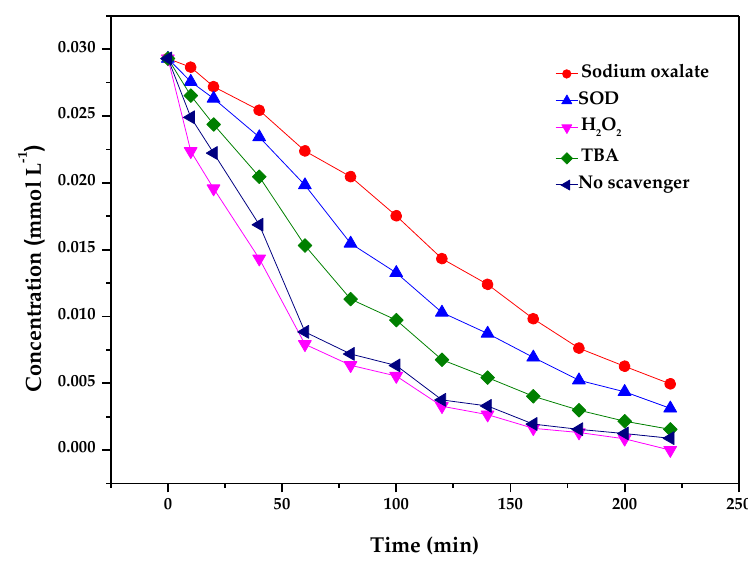
Figure 21. Photodegradation of methyl blue over ZnBiErO 4 in the presence of various scavengers: sodium oxalate, superoxide dismutase (SOD), H 2 O 2 , tert-butyl alcohol (TBA) and no scavenger.